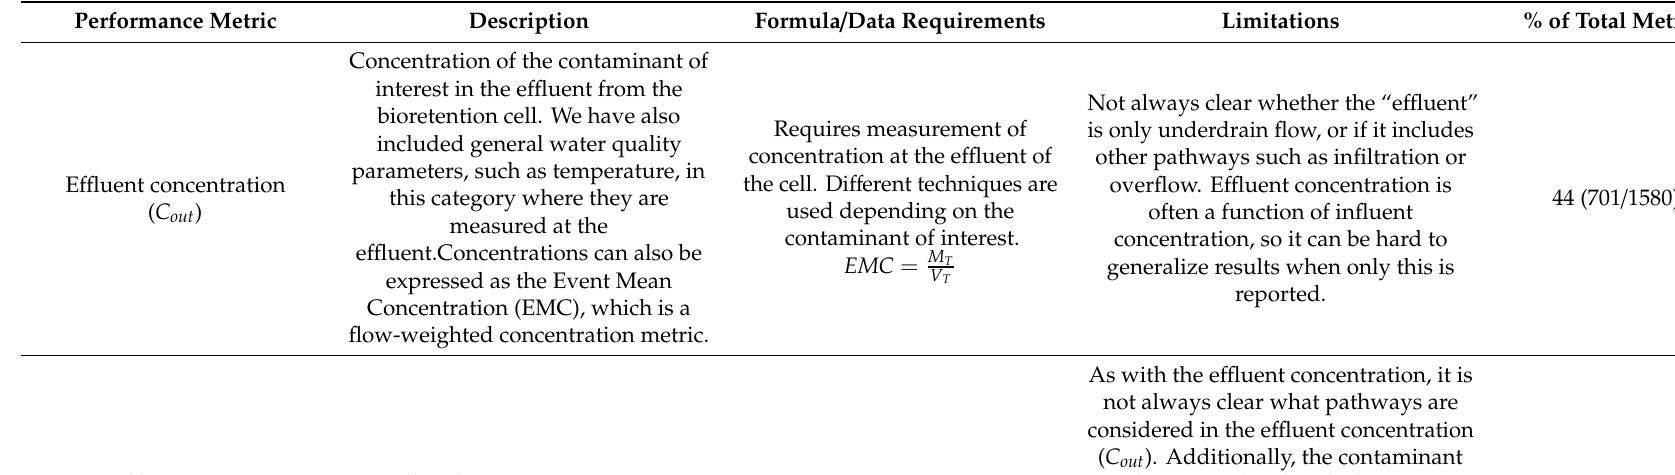
Table 5. Performance metrics used for evaluating contaminant transport and fate performance in bioretention cells. The percentage of total metrics gives the number of times each metric was used divided by the total number of metrics used in all contaminant fate and transport studies